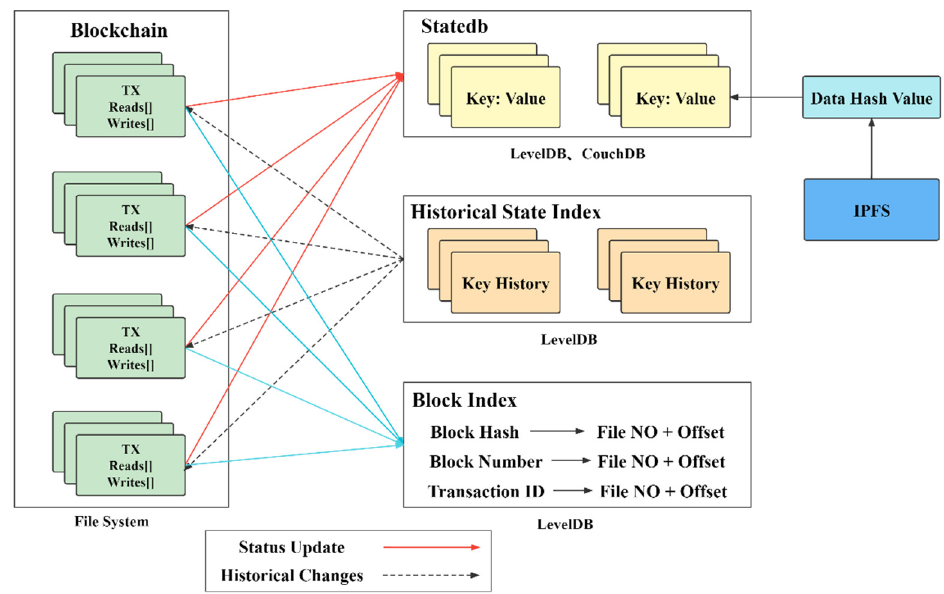
Figure 6. Data storage of blocks in blockchain and index connection between blocks.